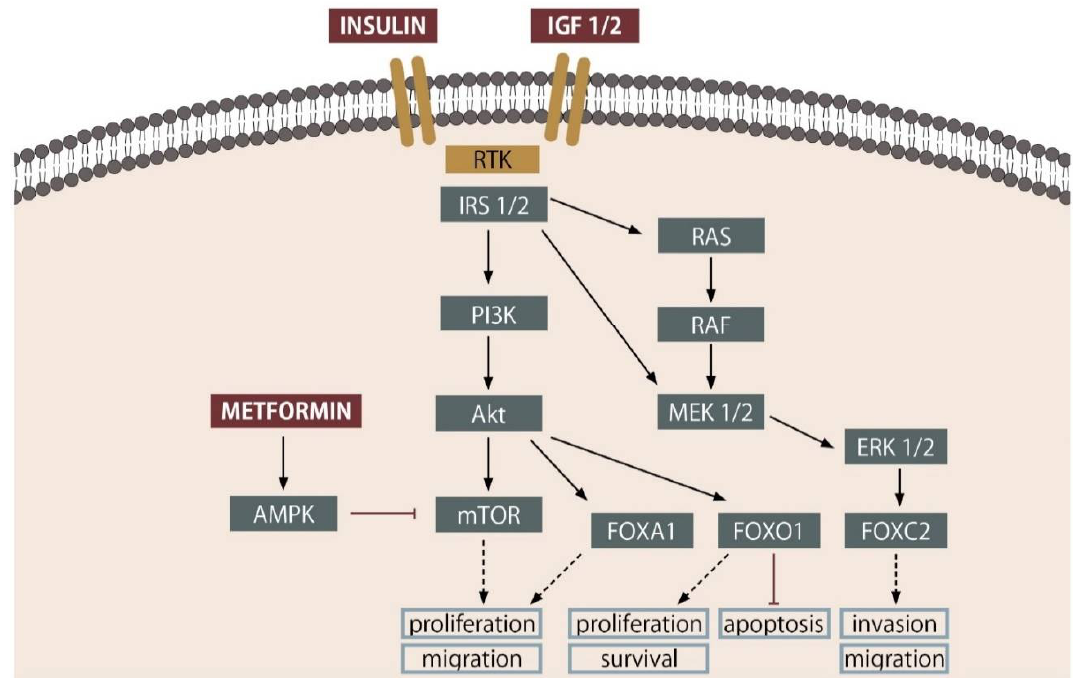
Figure 1. Influence of insulin and metformin on PC cells. Insulin in PC cells activates both MAPK/Erk1-2 and PI3K-Akt signaling pathways. mTOR and FOX-family proteins play a crucial role in the proliferation, migration and invasion. (Detailed description in text). RTK—Receptor tyrosine kinase, Akt—protein kinase B, IRS—Insulin Receptor Substrate Proteins, PI3K—Phosphoinositide 3-kinase, MEK—Mitogen-activated protein kinase kinase, RAS/RAF—Serine/threonine- specific protein kinases, ERK—extracellular signal-regulated kinases, mTOR—mechanistic target of rapamycin, AMPK— 5’AMP-activated protein kinase, FOX—forkhead box